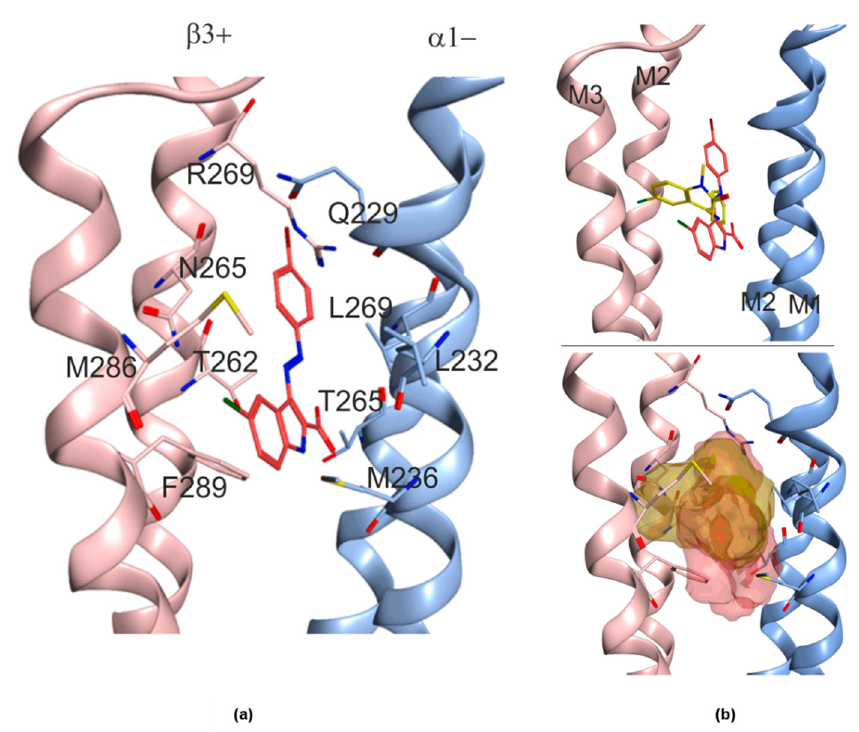
Figure 5. Representative docking pose of MTI163 in the diazepam pocket of 6HUP. ( a ) The MTI163 pose, which is fully consistent with all experimental evidence, is displayed with the pocket-forming amino acids that were set flexible during docking. ( b ) Overlay of diazepam (yellow) and the MTI163 (red) pose in 6HUP ligands structures (top), ligands surfaces (bottom). The left subunit (pink) is β 3, the right one (blue) is α 1.